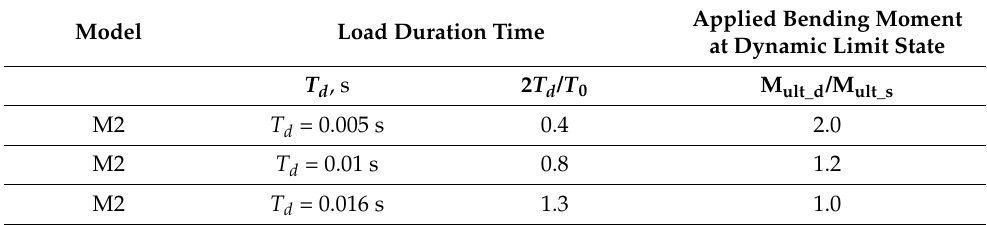
Table 3. Dynamic ultimate strength of the box girder.